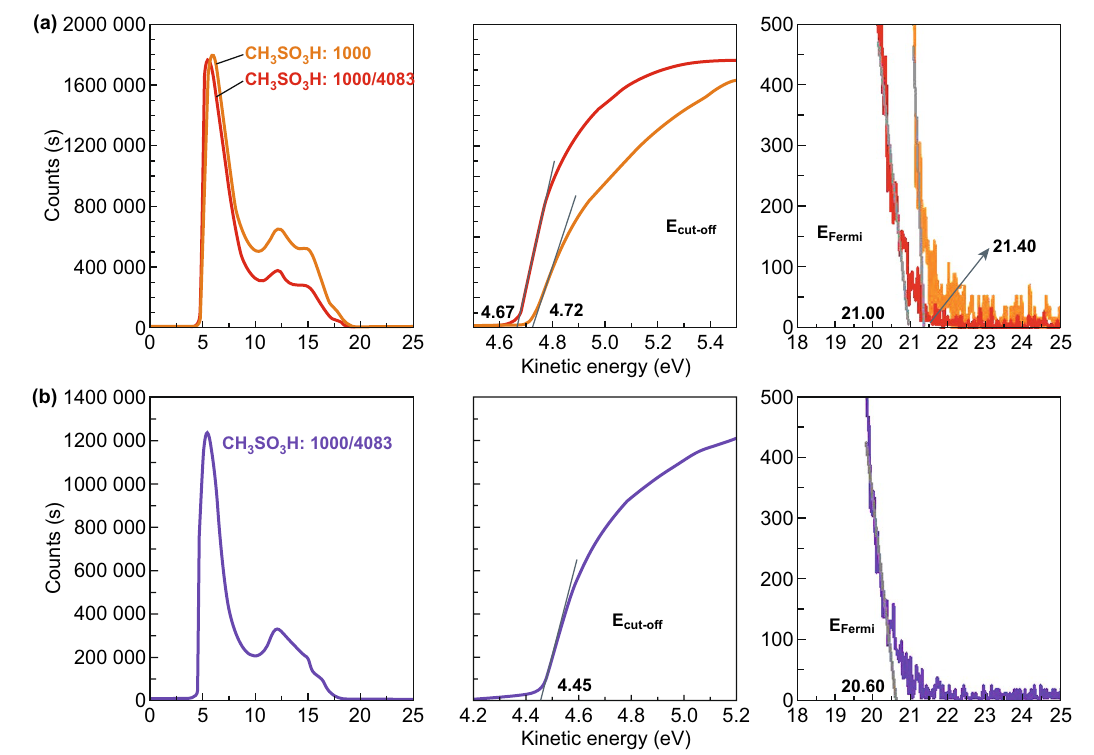
Fig. 5 Work functions of the films. a UPS of the polymeric anodes with CH 3 SO 3 H treatments and the PEDOT:PSS (P VP AI4083)-coated anodes. b UPS of the CF 3 SO 3 H-doped anodes coated with PEDOT:PSS (P VP AI4083) buffer